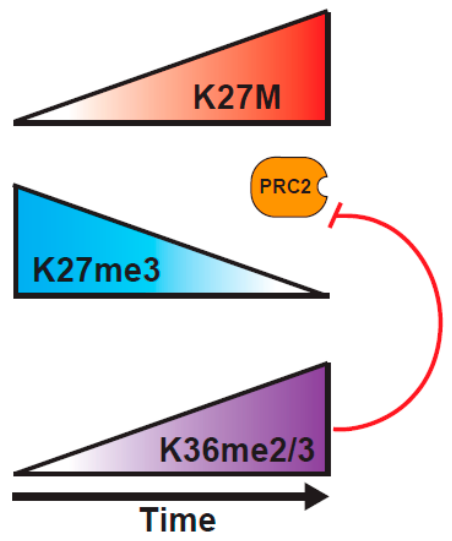
Figure 3. Revised views of K27M mutant H3 function. Induction of K27M recruits PRC2 to novel loci. K27M blocks PRC2 activity, causing global decrease in K27me3, with islands of retention of K27me3 at high affinity PRC2 recruitment sites. Transcriptional change on the loss of K27me3 promotes K36 methylation which further suppresses PRC2 activity [82]. Loss of K27me3 from bivalent promoters induces the expression of genes associated with neural development [75].